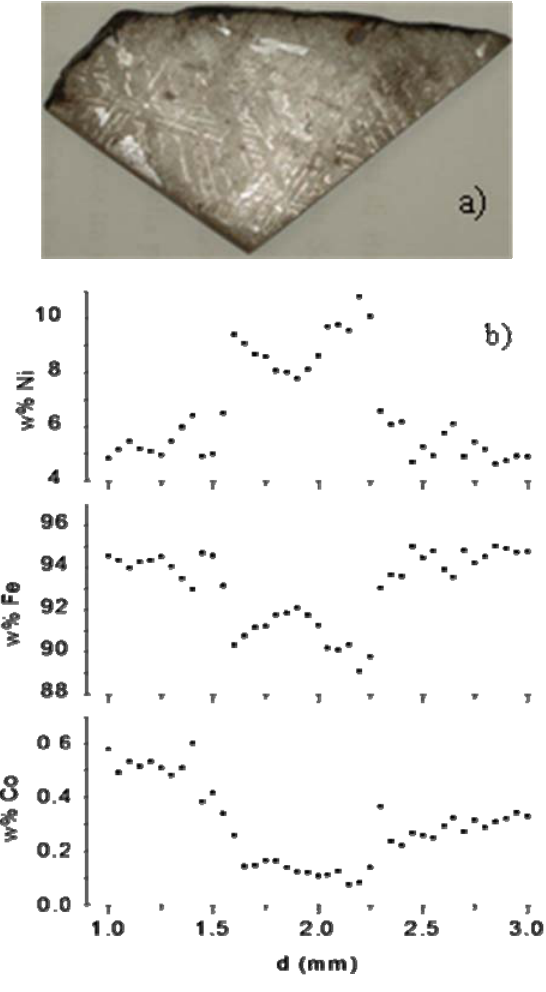
Figure 6. (a) Slab of Toluca iron meteorite (medium octahedrite, class IAB) displaying on its surface the peculiar Widmanstätten pattern; (b) weight percentage profile of Ni, Fe and Co across one lamella of the Widmanstätten structure of